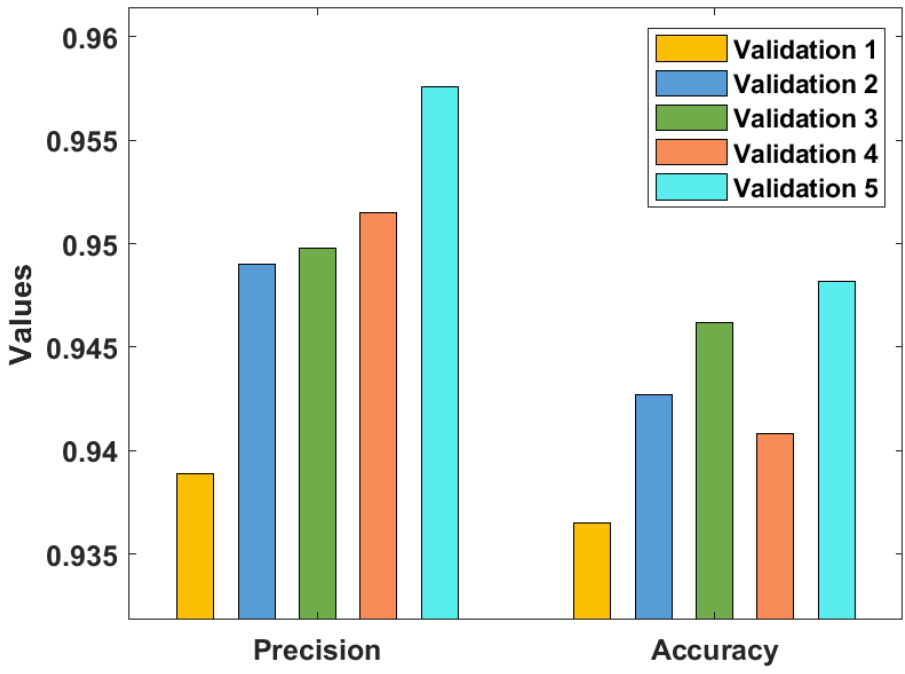
Figure 6. Result analysis of the GSO-IDCNN technique with respect to 𝑃𝑟𝑒𝑐